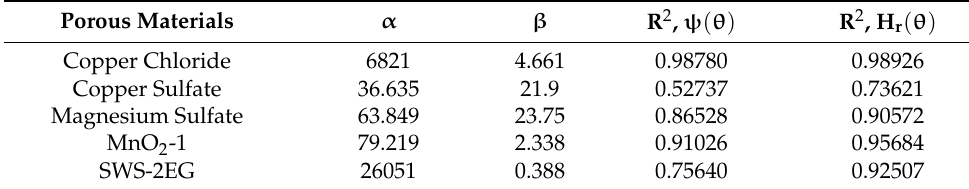
Table 1. Estimation of α and β for each material.